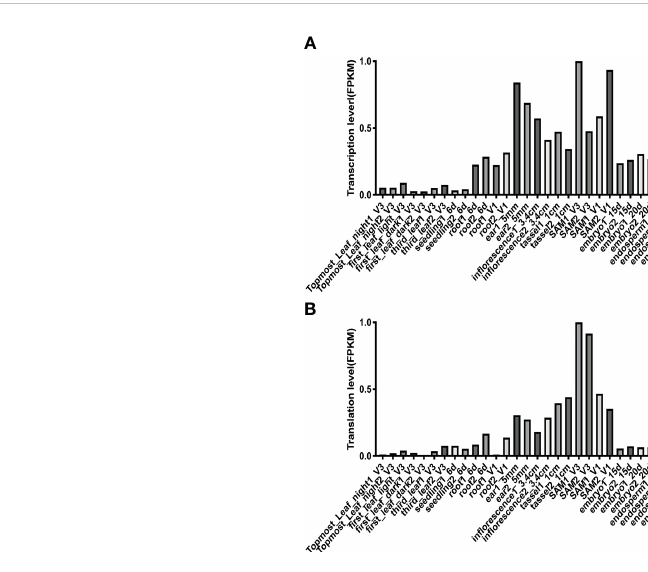
FIGURE 3 Expression of ZmHOX32 gene in maize tissues. (A) Transcription of ZmHOX32 gene. (B) Translation of the ZmHOX32 gene.